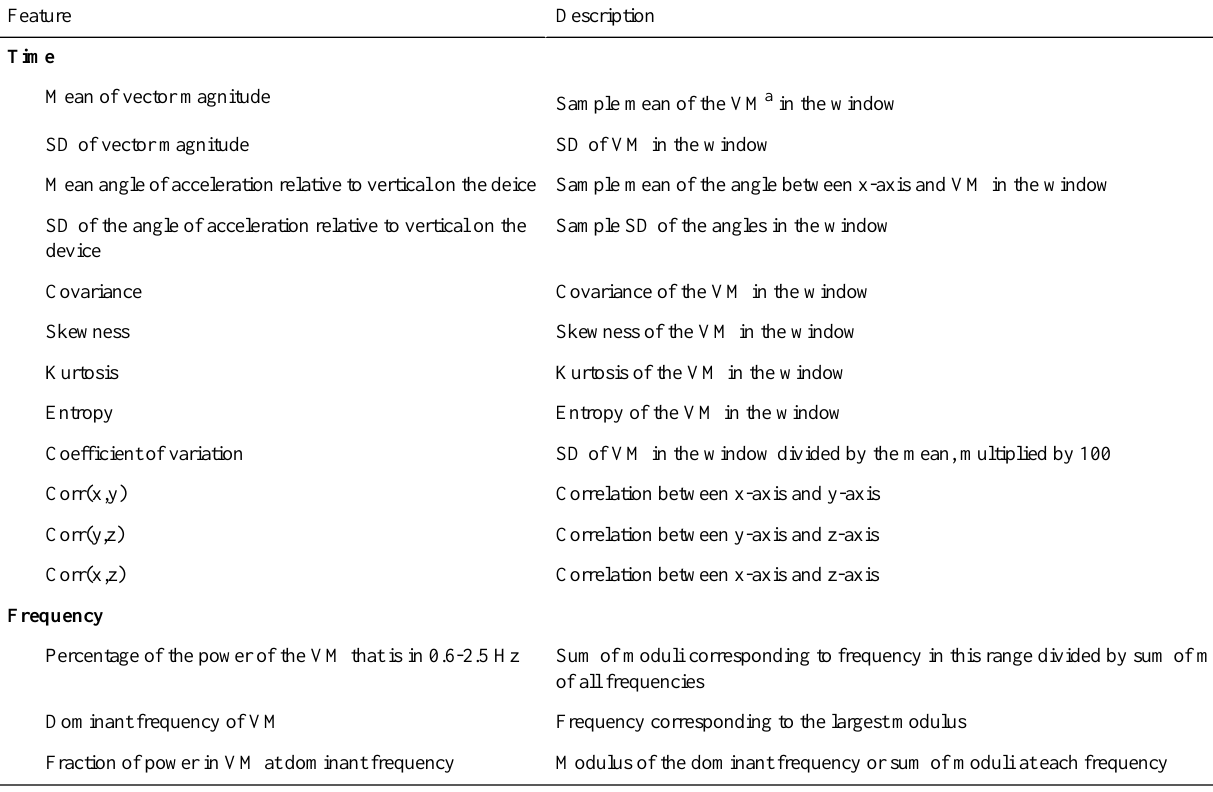
Table 1. Description of features extracted from the raw data. DescriptionFeature